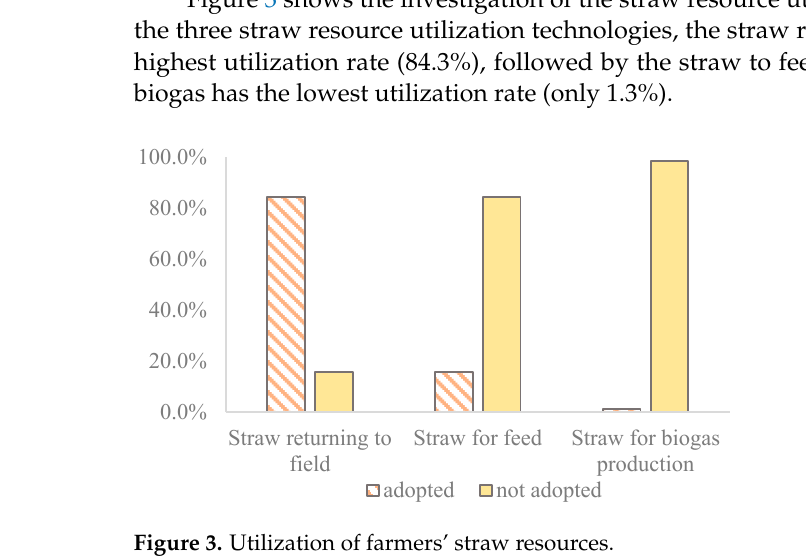
Table 1. Classification of straw resource utilization.